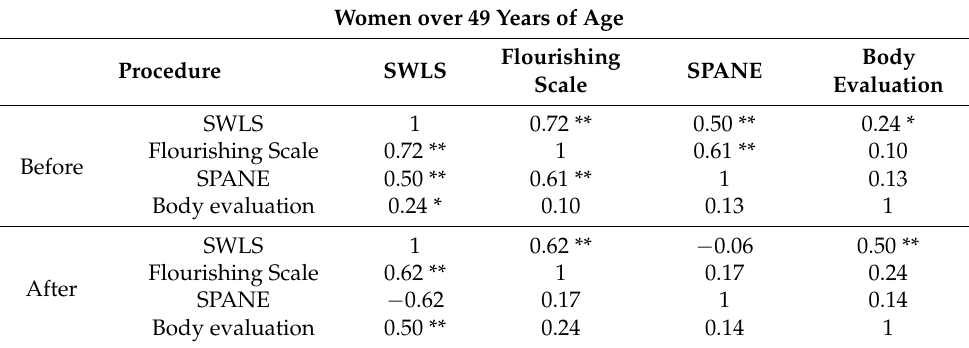
Table 8. Correlations of various forms of well-being and body self-esteem in patients over 49 years of age.